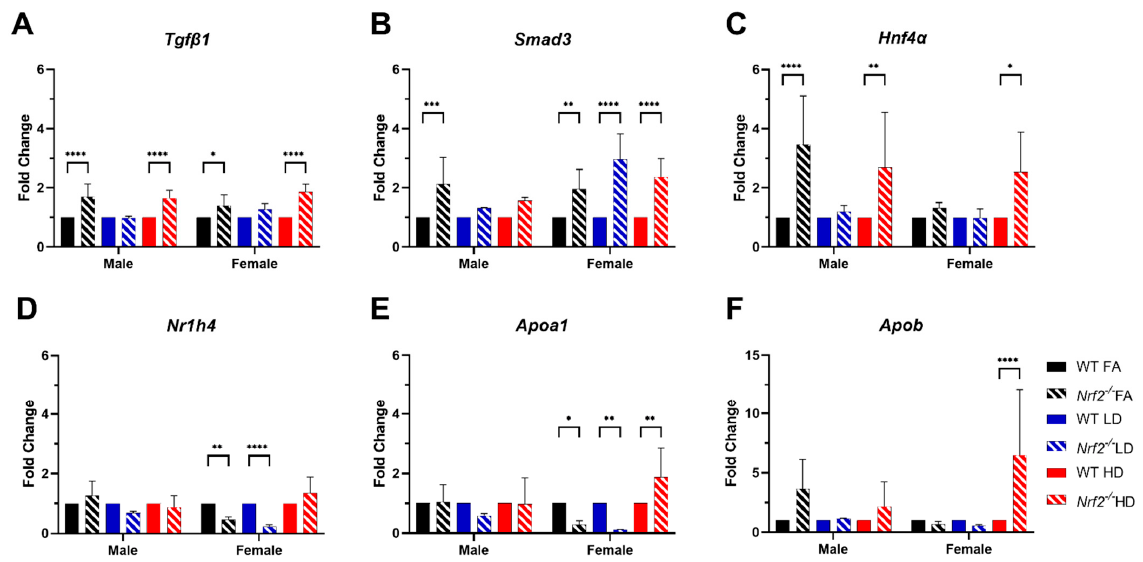
Figure 7. Placental gene expression. Fold change of Tgf β 1 ( A ), Smad3 ( B ), Hnf4 α ( C ), Nr1h4 ( D ), Apoa1 ( E ), and Apob ( F ). Error bars represent SD. Data analyzed using two-way ANOVA with Tukey’s multiple comparison test. (* p < 0.05; ** p < 0.01; *** p < 0.001; **** p < 0.0001). Sample sizes shown in Figure 6.